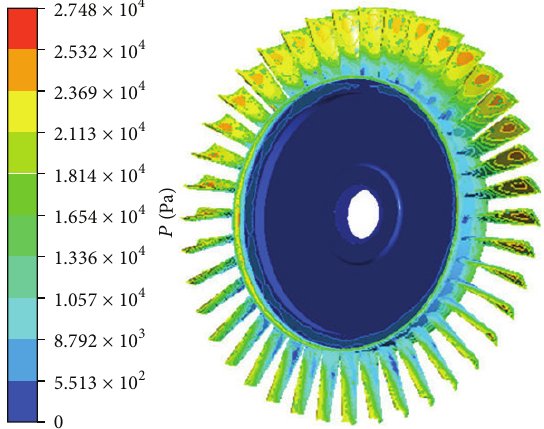
Figure 4: Static pressure distribution of blisk surface.